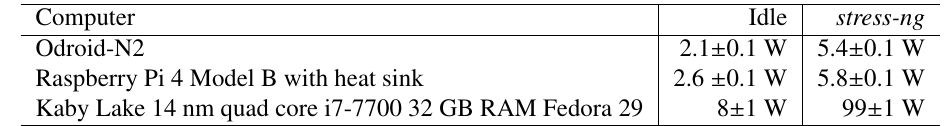
Table 2. Power measurements.